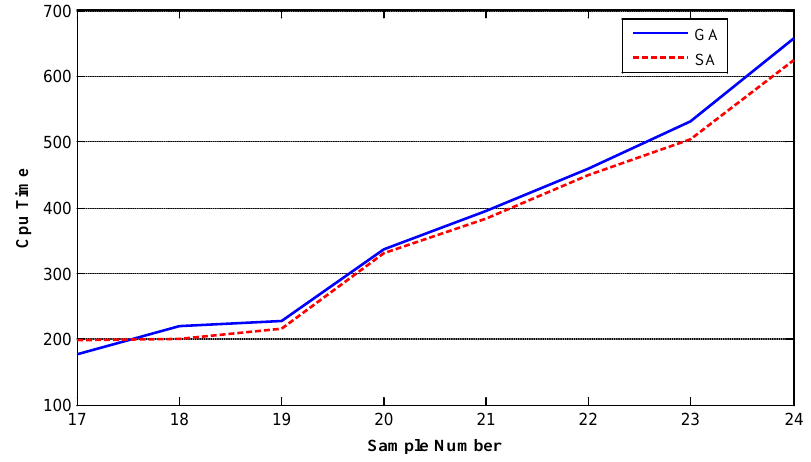
Fig. 6. Comparison of computational time of the GA and SA in large size